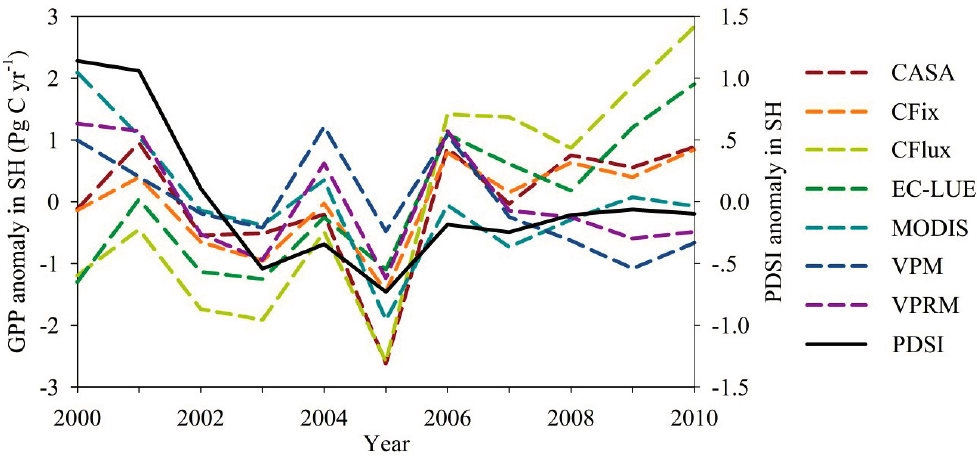
Figure 4. Interannual variations of annual GPP estimates and PDSI over the Southern Hemisphere